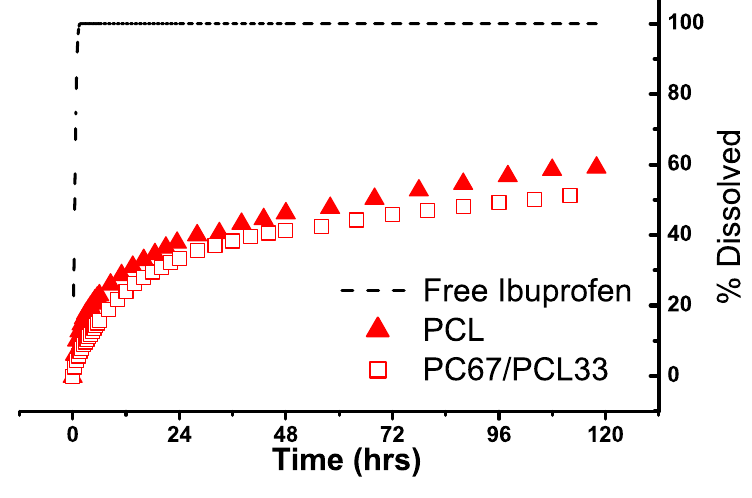
Figure 8. Dissolution profiles of free ibuprofen, PCL and